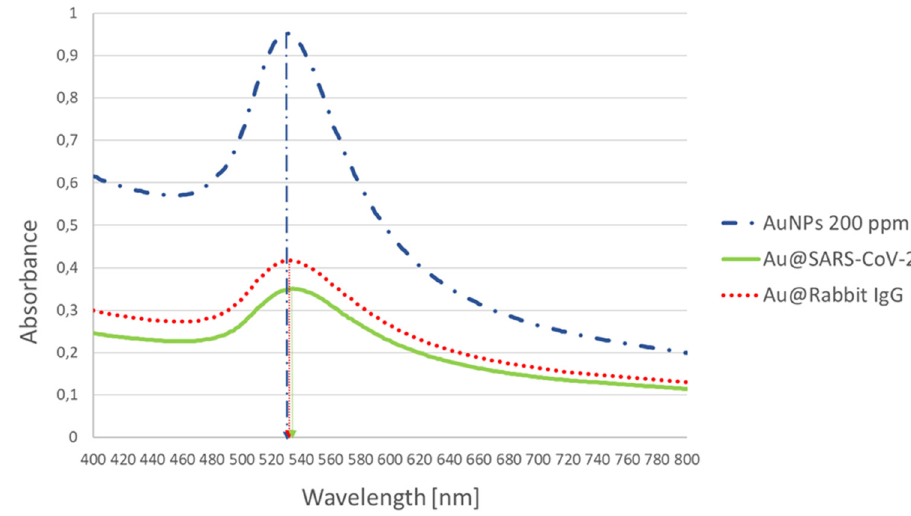
Figure 4: UV - Vis spectrum of: Unconjugated AuNPs ( 200 ppm ) , Au@SARS - CoV - 2: AuNPs conjugated with SARS - CoV - 2 antigens, and Au@Rabbit IgG: AuNPs conjugated with Rabbit IgG antibodies.